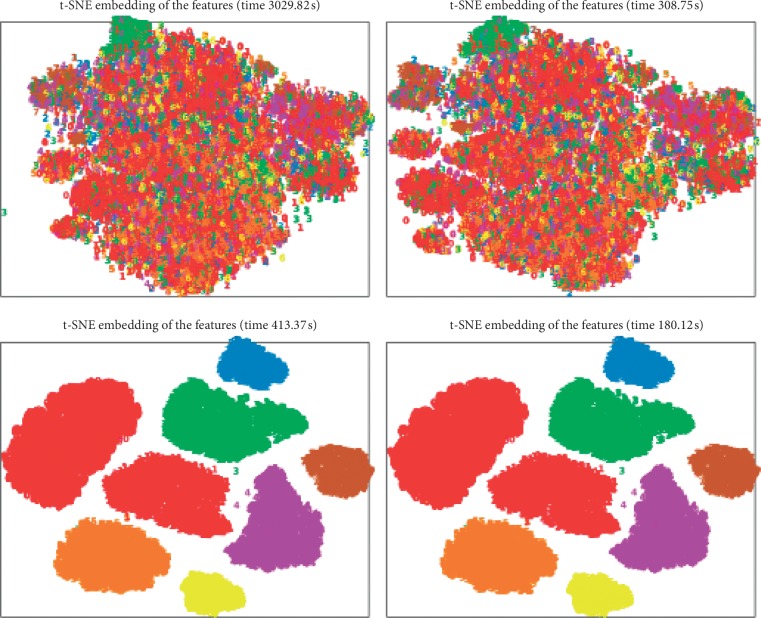
Visualization of the extracted features for the training data by t-SNE. The first row is for the 14th layer, and the second row is for the 24th layer. The left column is the original features, and the right column is the features after PCA.